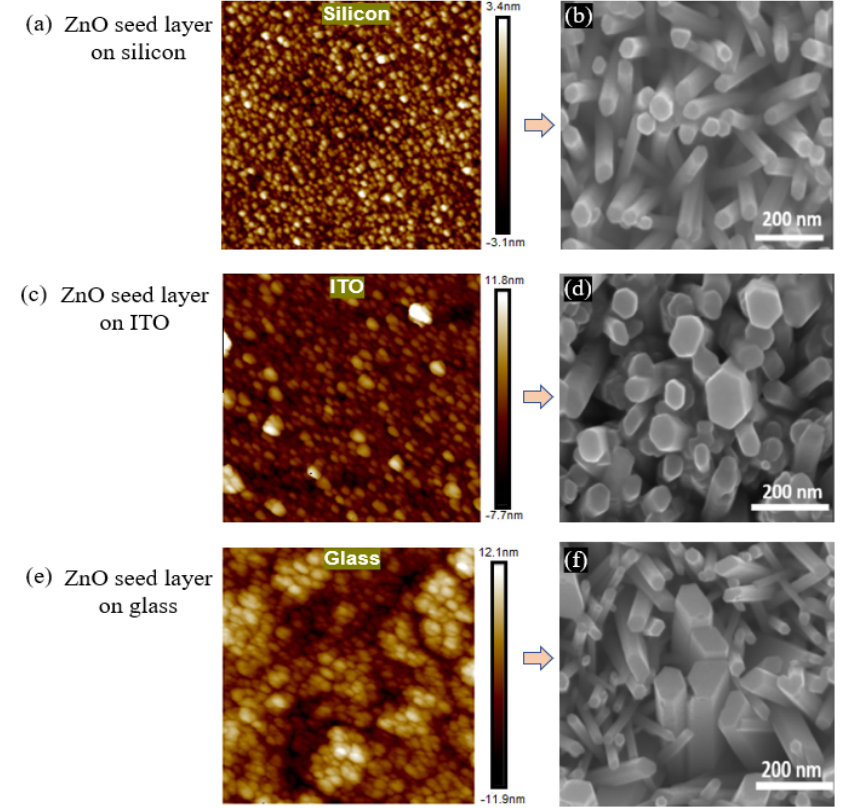
Figure 5. AFM images of the seed layer and FESEM images of ZnO NRs grown on different substrate materials ( a , b ) silicon, ( c , d ) ITO, and ( e , f ) microscopy glass slides. Reprinted with permission from ref. [89]. Copyright 2021 Elsevier.